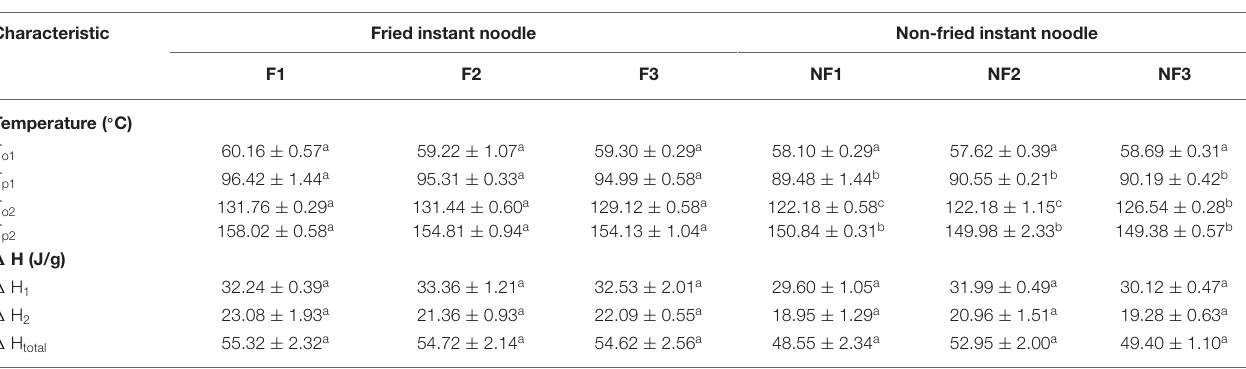
TABLE 3 | Thermal properties of fried and non-fried instant